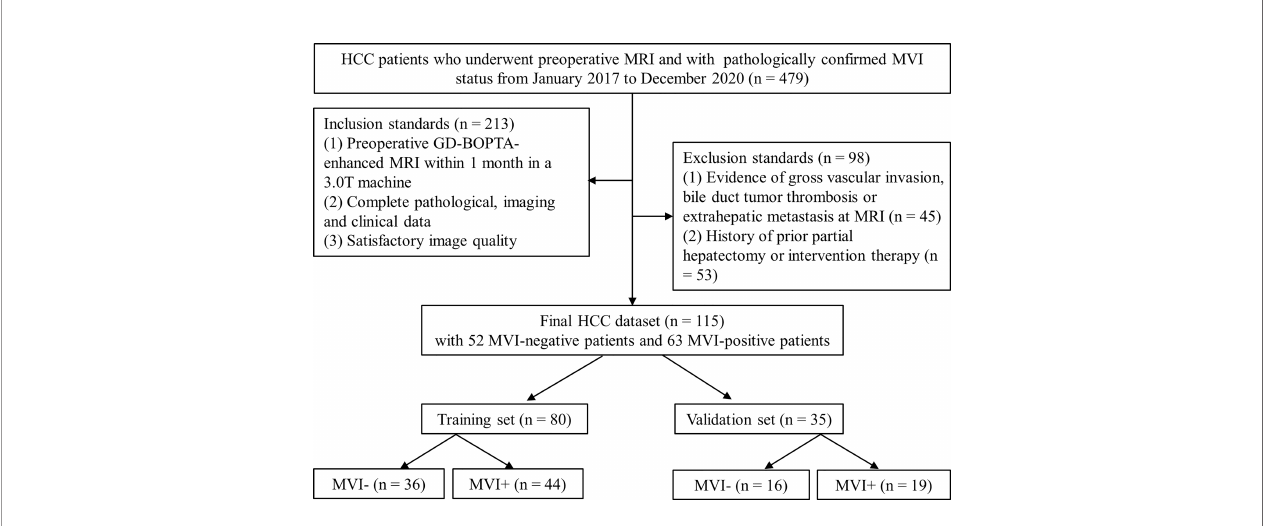
FIGURE 1 | Flowchart of patients enrolled in the